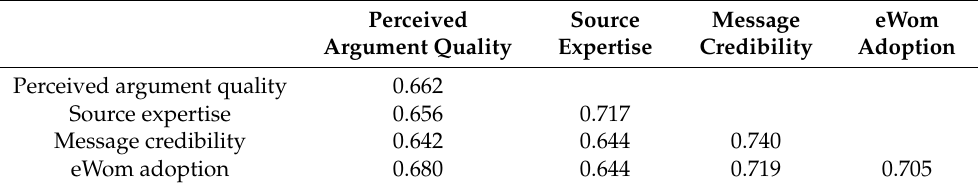
Table 2. Average variance extracted and construct squared